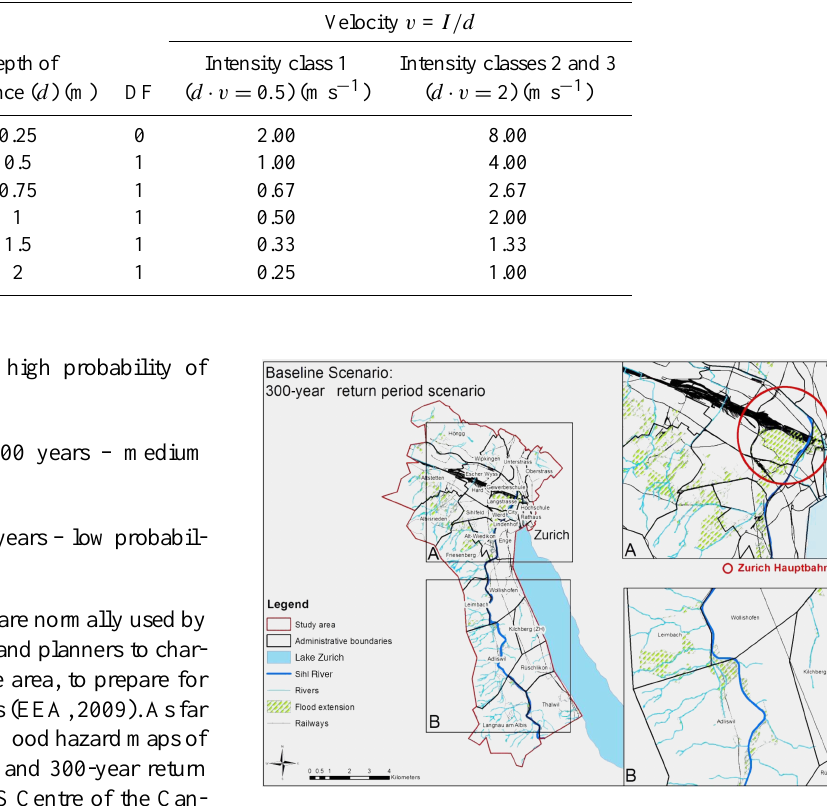
Table 6. Computation of (individual) values of velocity ( v ) from available data (water depth – d , debris factor – DF, and intensity – I ).